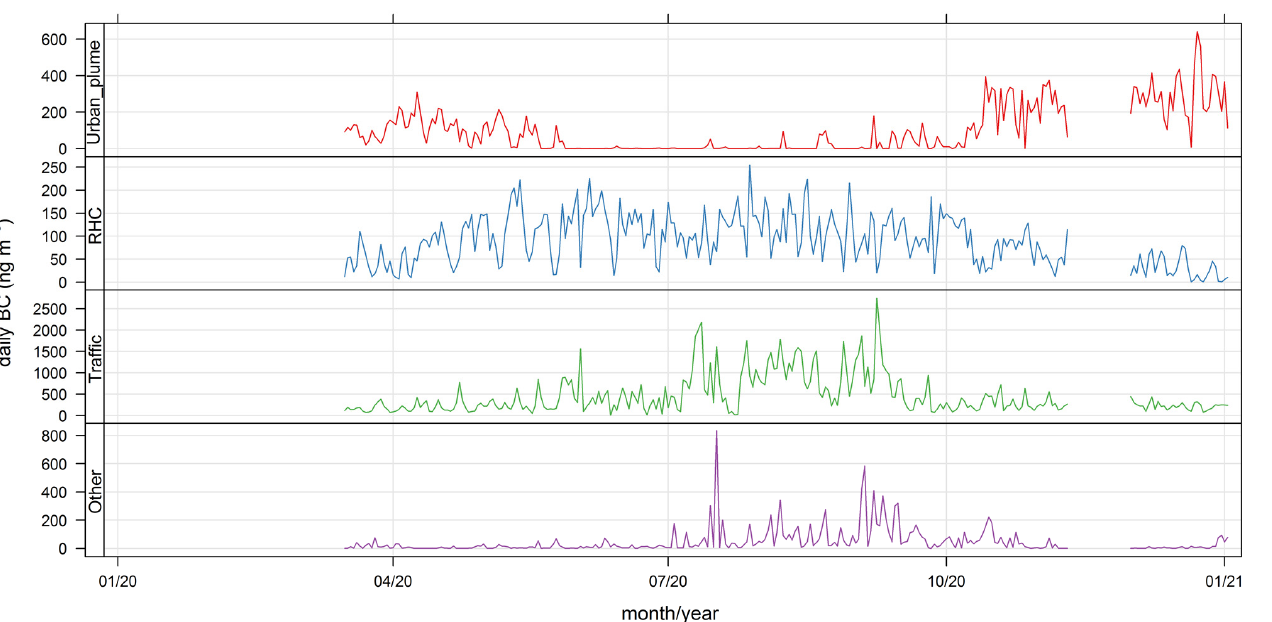
Figure 10. Time plot of daily source contributions to BC wb . 4. Discussion This is the first report of BC source apportionment conducted in Santiago, Chile that includes the effects of lockdowns brought on by the SARS-CoV-2 pandemics. Hence, the results reported here may be considered a baseline for future studies. The total BC reductions associated with Santiago 2020 lockdowns—from 40% to 80%—are like the ones estimated for other cities worldwide: Delhi, India [25], up to 78%; Kigali, Rwanda [29], 59%; Sommerville, MA, USA [28], 22–56%; Wuhan, China [31], 39%. One limitation of our estimated reduction is that the baseline is not 2019 but 2015; since